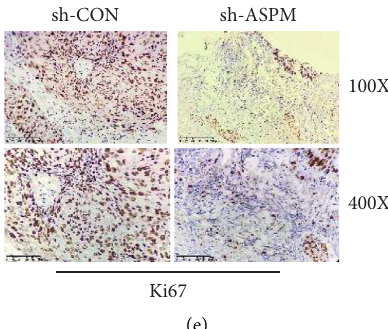
Figure 5: ASPM promotes subcutaneous tumor growth in nude mice. (a) Tumor volume and mice body weight. (b) Tumor weight and gross morphology. (c) ASPM expression was evaluated by immunohistochemistry. (d) H&E staining of tumor tissues. (e) Ki67 staining in tumor tissues. ∗∗∗ P < 0 .